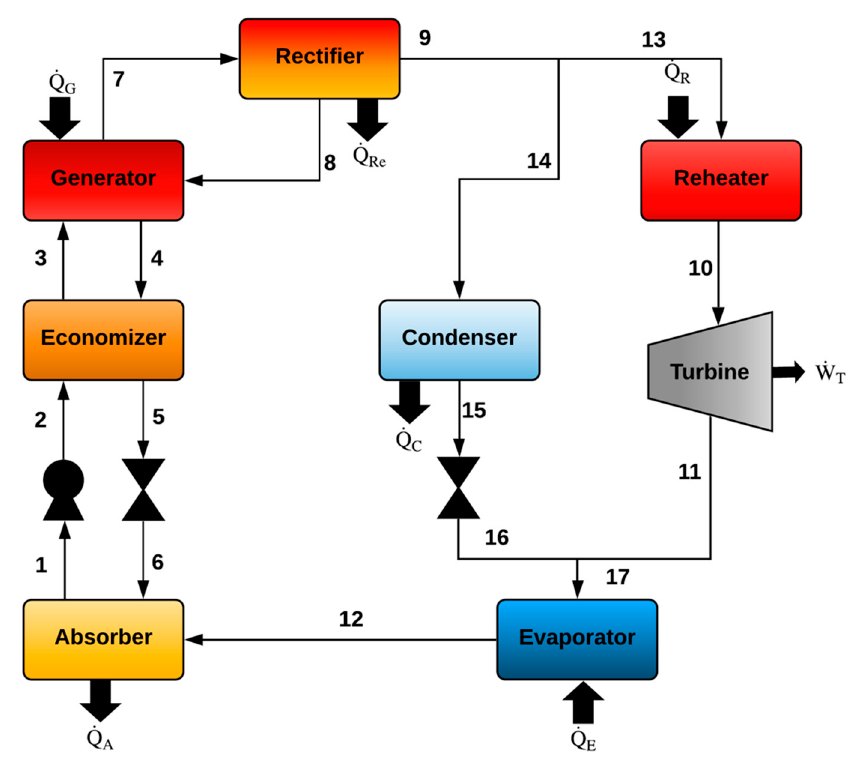
Figure 2. Goswami cycle with a condenser and a flow division after the rectifier.